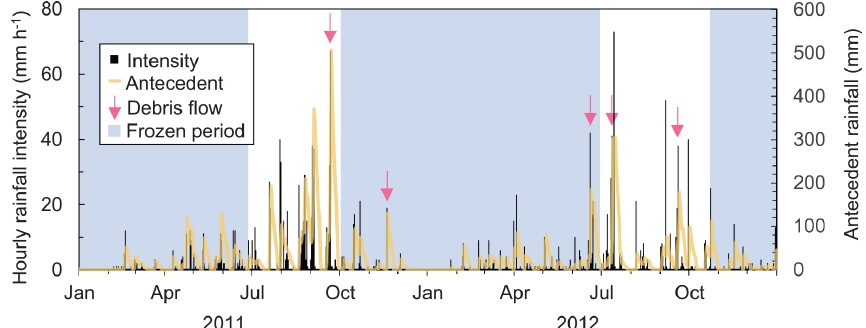
Figure 6. Seasonal changes in the rainfall pattern in the period 2011–2012, when debris flows occurred successively. The timing of the debris flow events is also illustrated. Frozen periods were estimated by the degree-day method. Antecedent rainfall was determined using Eq. (5).